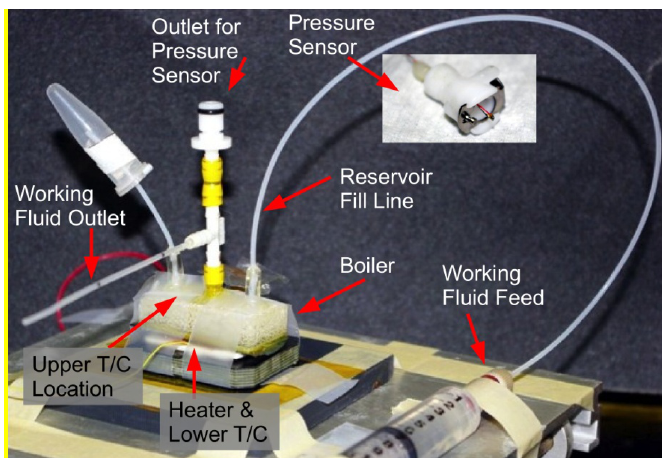
Figure 6. Boiler test